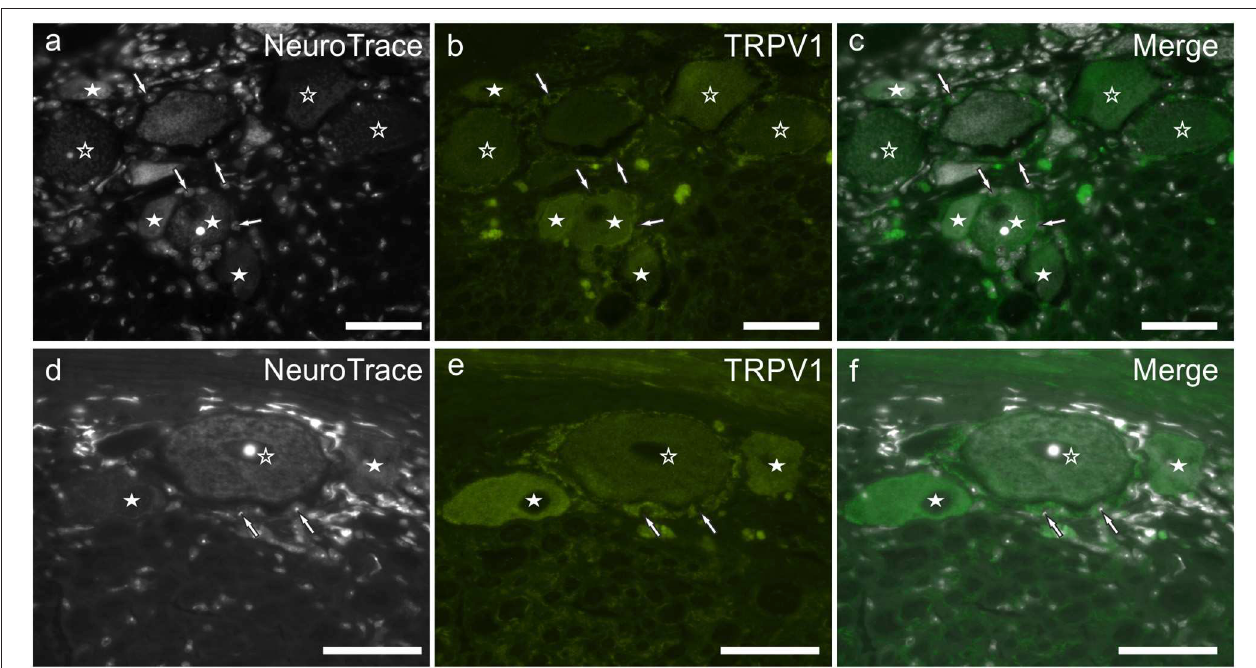
FIGURE 5 | (a–f) Photomicrographs of cryosections of the C8 cervical dorsal root ganglia belonging to two aged dogs showing transient receptor potential vanilloid type 1 (TRPV1) immunoreactivity. White stars indicate neurons showing bright TRPV1 immunoreactivity, while open stars indicate larger neurons showing weaker TRPV1 immunoreactivity. Arrows indicate the Neurotrace labeled nuclei of satellite glial cells showing bright TRPV1 immunolabeling (b,e) . Bar: a–f = 50 µ m.